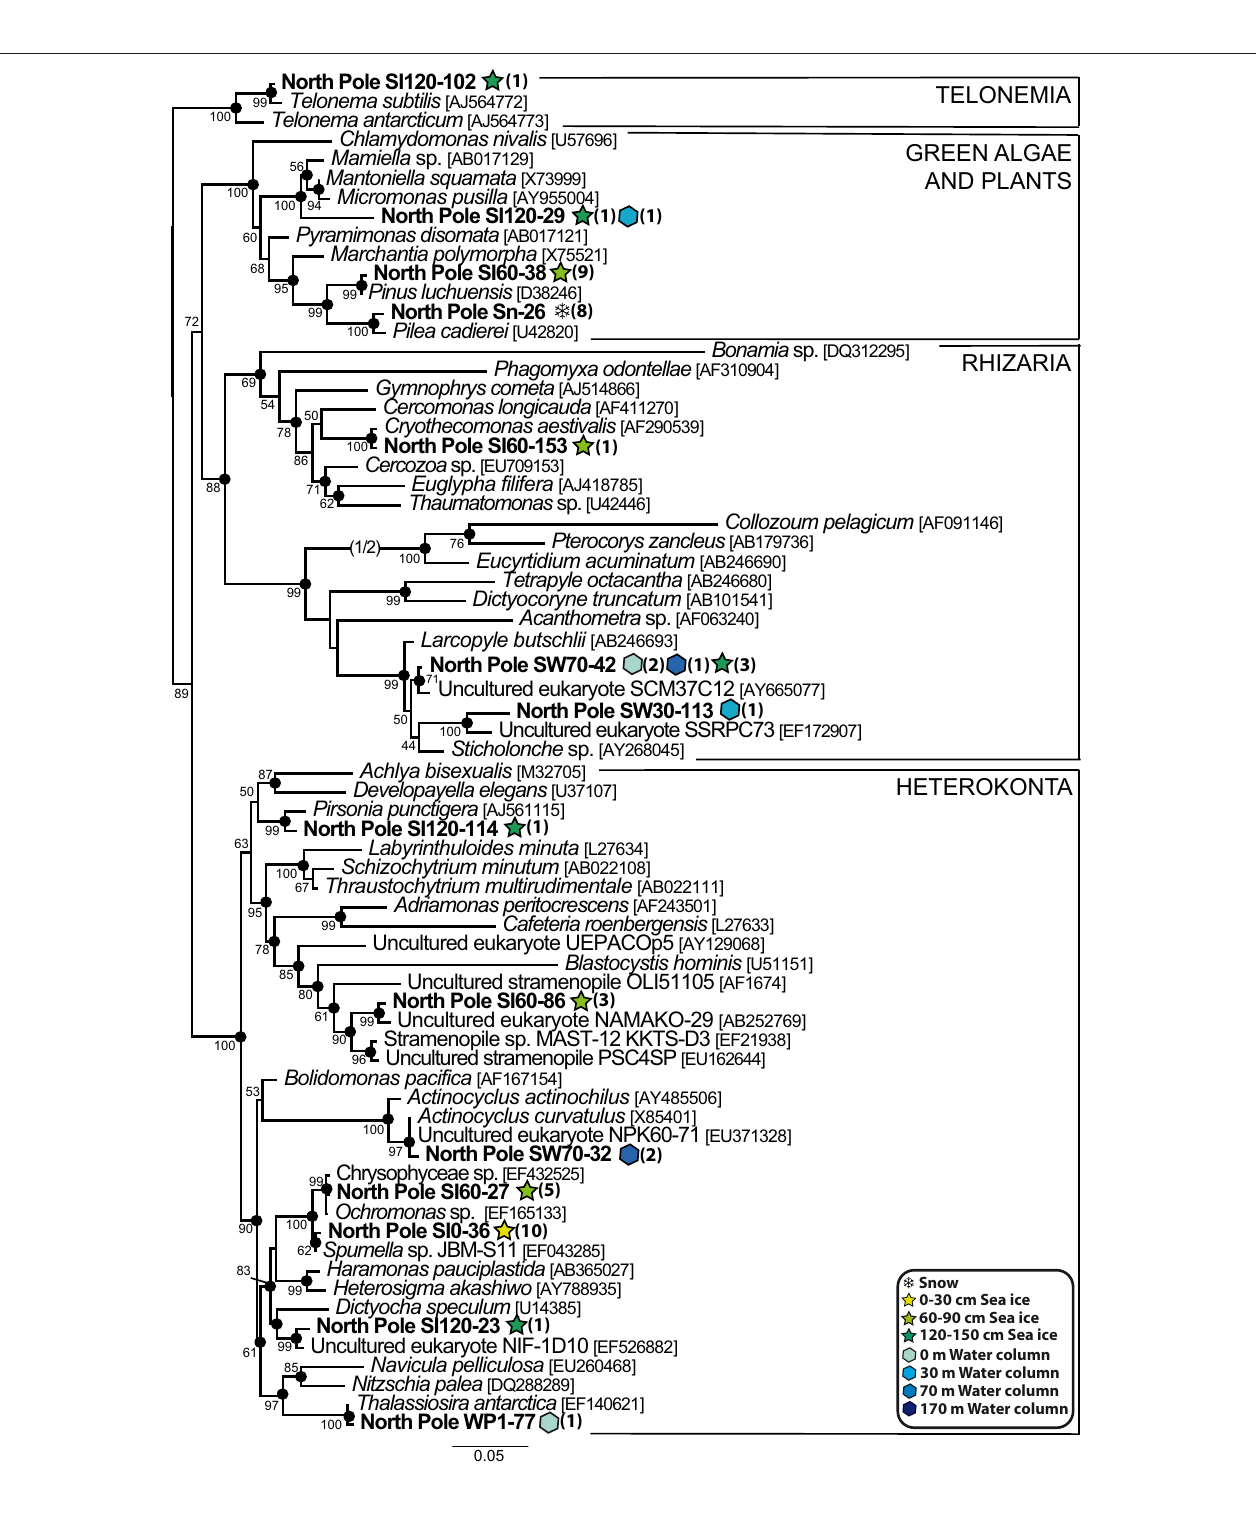
Figure 8 | Maximum likelihood phylogenetic tree of diverse heterokont, green algae and plant, telonemid and rhizarian phylotypes.